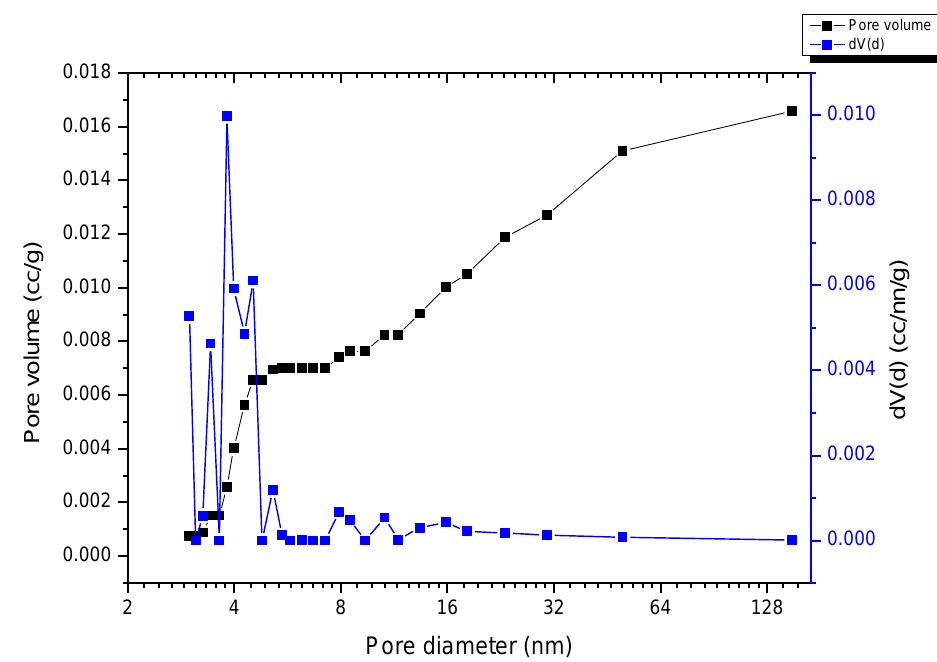
Figure 9. BJH desorption of the 7B (red sample).